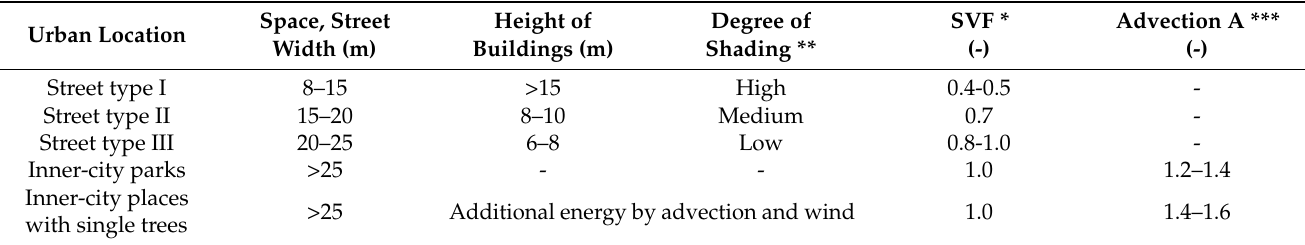
Table 3. Combination of the SVF coefficients according to Gong et al. [35] and Costello et al. [37], and advection coefficients (A) according to Bohne [40] and Schwärzel and Bohl [41] for various urban sites. Urban